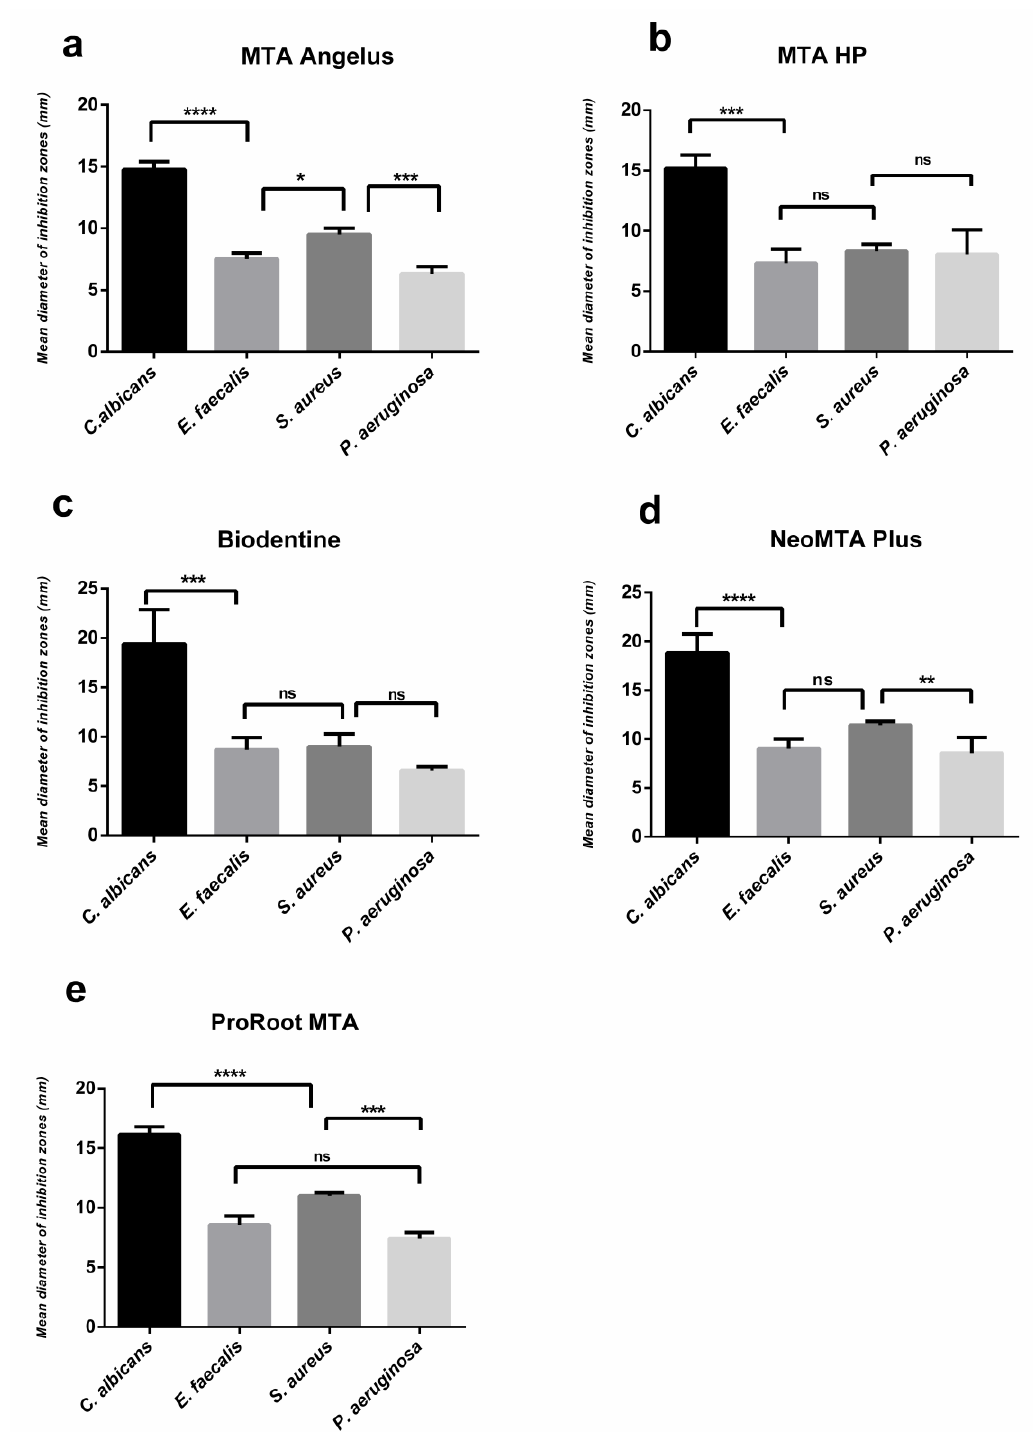
Figure 3. Inhibitory e ff ect of each tested cement against per microorganism at the end of 48h. Results are expressed as mean values + SD (**** p < 0.0001; ***, p < 0.001; **, p < 0.01; *, p < 0.05; ns: no significance). ( a ) Inhibitory e ff ect of MTA Angelus, ( b ) Inhibitory e ff ect of MTA HP, ( c ) Inhibitory e ff ect of Biodentine, ( d ) Inhibitory e ff ect of NeoMTA Plus, ( e ) Inhibitory e ff ect of ProRoot MTA.